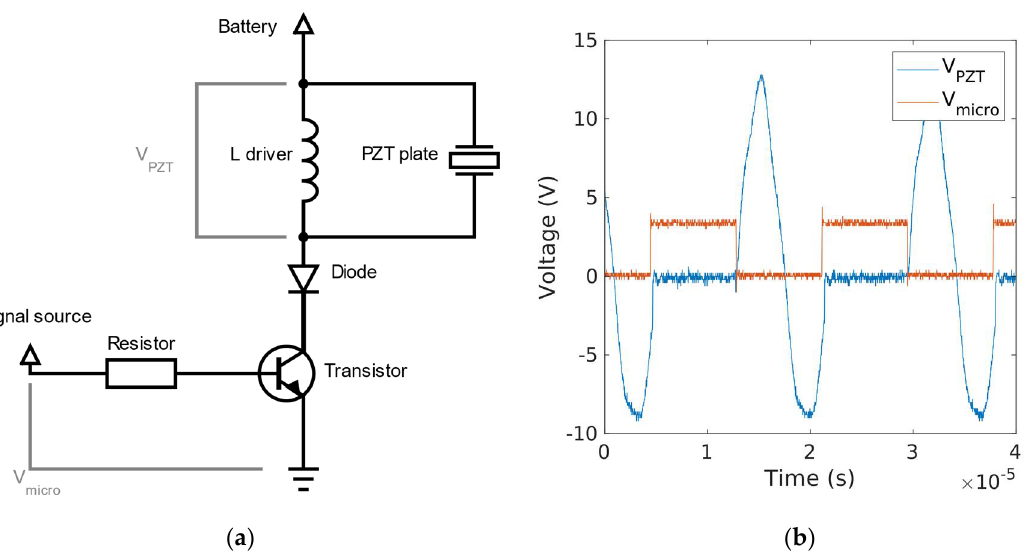
Figure 6. ( a ) Inductor-based interface circuit. ( b ) Measured PWM signal from microcontroller (orange) and voltage between PZT plate terminals (blue).